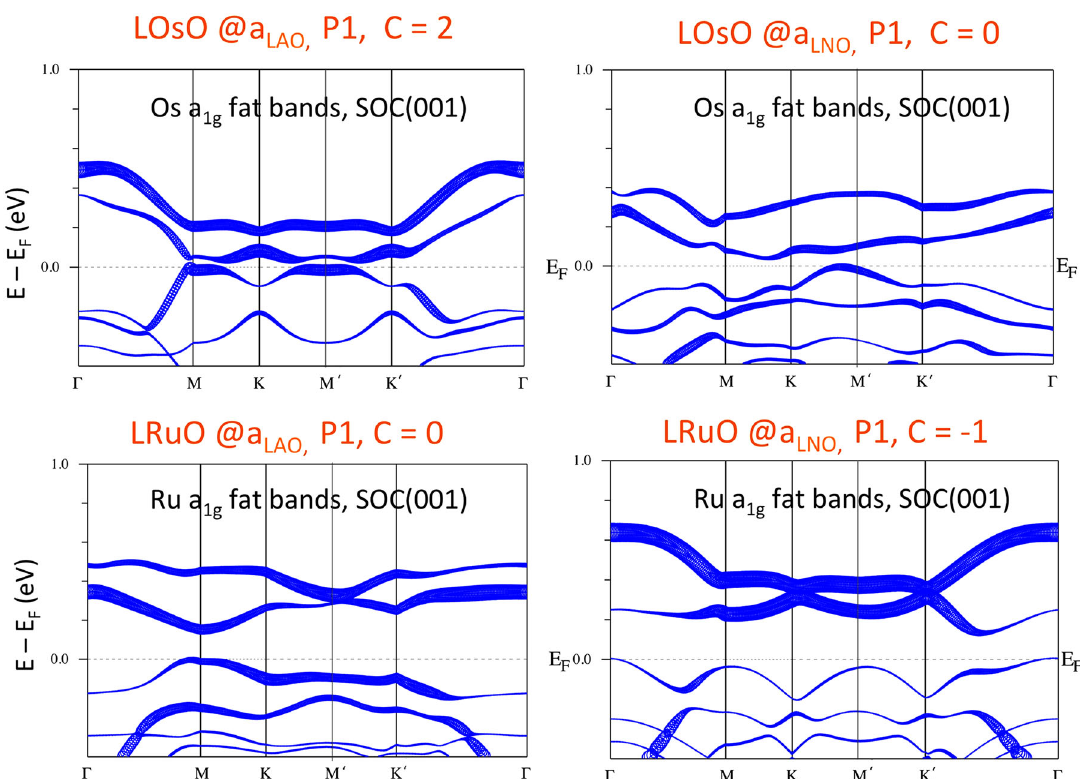
Fig. 3 Fat band plot highlighting the a 1 large a 1 hole character, which as these results demonstrate is sensitive to g